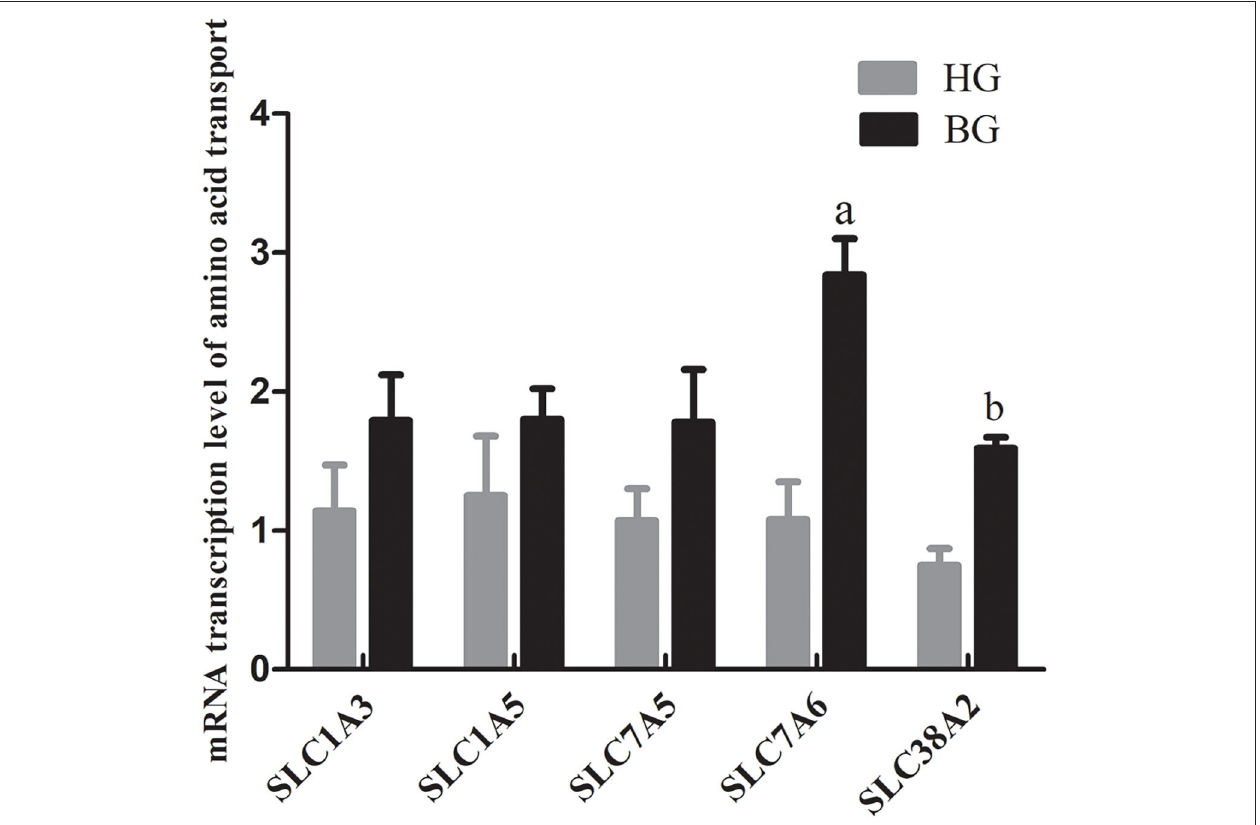
FIGURE 4 | mRNA expressions of amino acid transport SLC1A3, SLC1A5, SLC7A5, SLC7A6, and SLC38A2. Each sample was first normalized against its GAPDH transcript level, and then normalized to the HG. In order to calculate differences in the expression level of each target gene, the 2 − 11 Ct method for relative quantification was used, according to the manufacturer’s manual. Values are mean ± SEM. n = 6/group. b p < 0.05 and a p < 0.01, compared with high grain